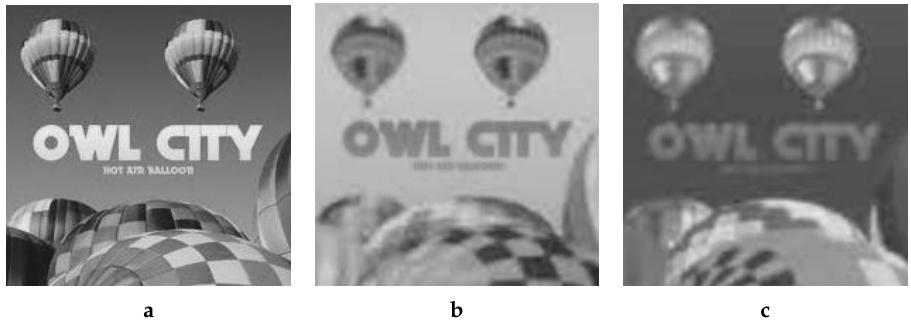
Figure 8. Luminance/Chrominance components of the forged image. ( a ) Y, ( b ) Cb, ( c ) Cr. Applying inverse color transform to YCbCr resulted in RGB image (A’) in Figure 3c.